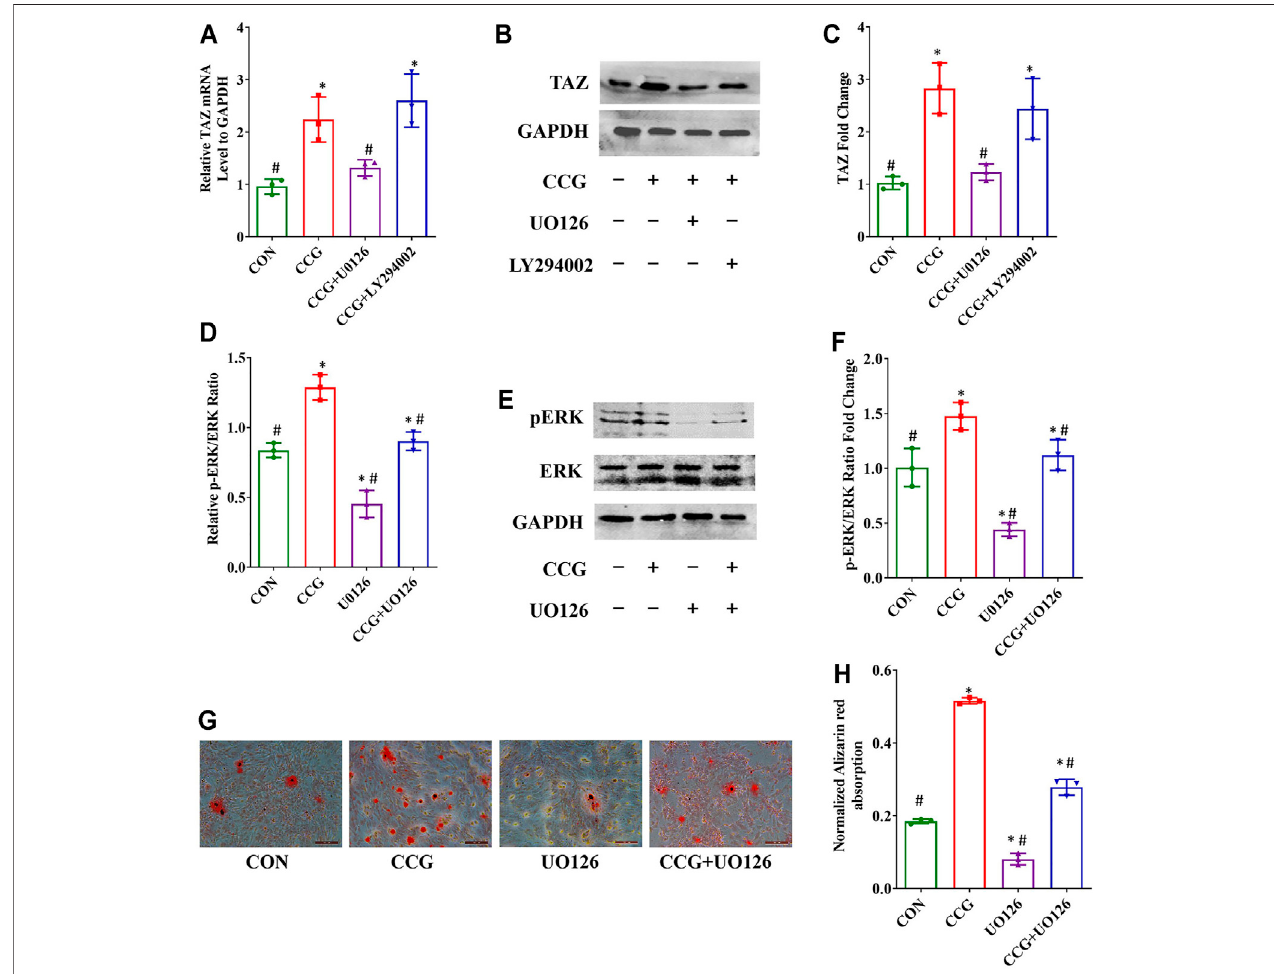
FIGURE 5 | Osteogenic differentiation and TAZ expression were increased by CCG treatment by increasing the p-ERK/ERK ratio. (A – C) Relative mRNA and protein levels toGAPDHofTAZat Day 3indifferentgroups. (D – F) Relative mRNA and protein levels ofp-ERK atDay 3in differentgroups. (G, H) Representativeimages ofAR-Sshowedthecalciumdepositswerein fl uenced byCCG treatment.Scalebar:100 μ m* p < 0.05vs.thecontrolgroup(cellsculturedinosteogenicmediumduring osteogenesis); # p < 0.05 vs. the CCG administration group.